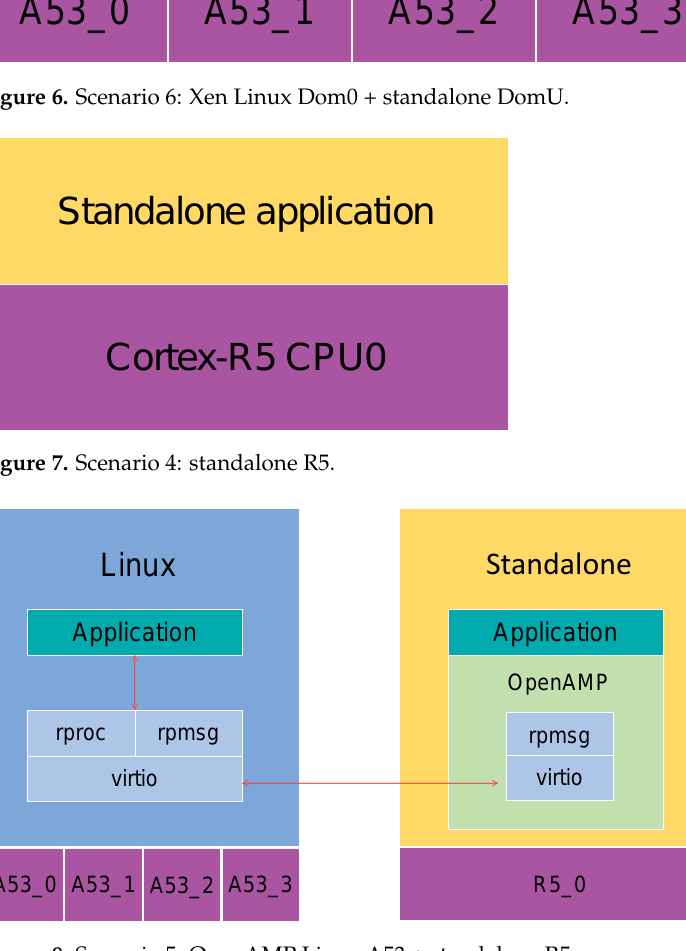
Figure 8. Scenario 5: OpenAMP Linux A53 + standalone